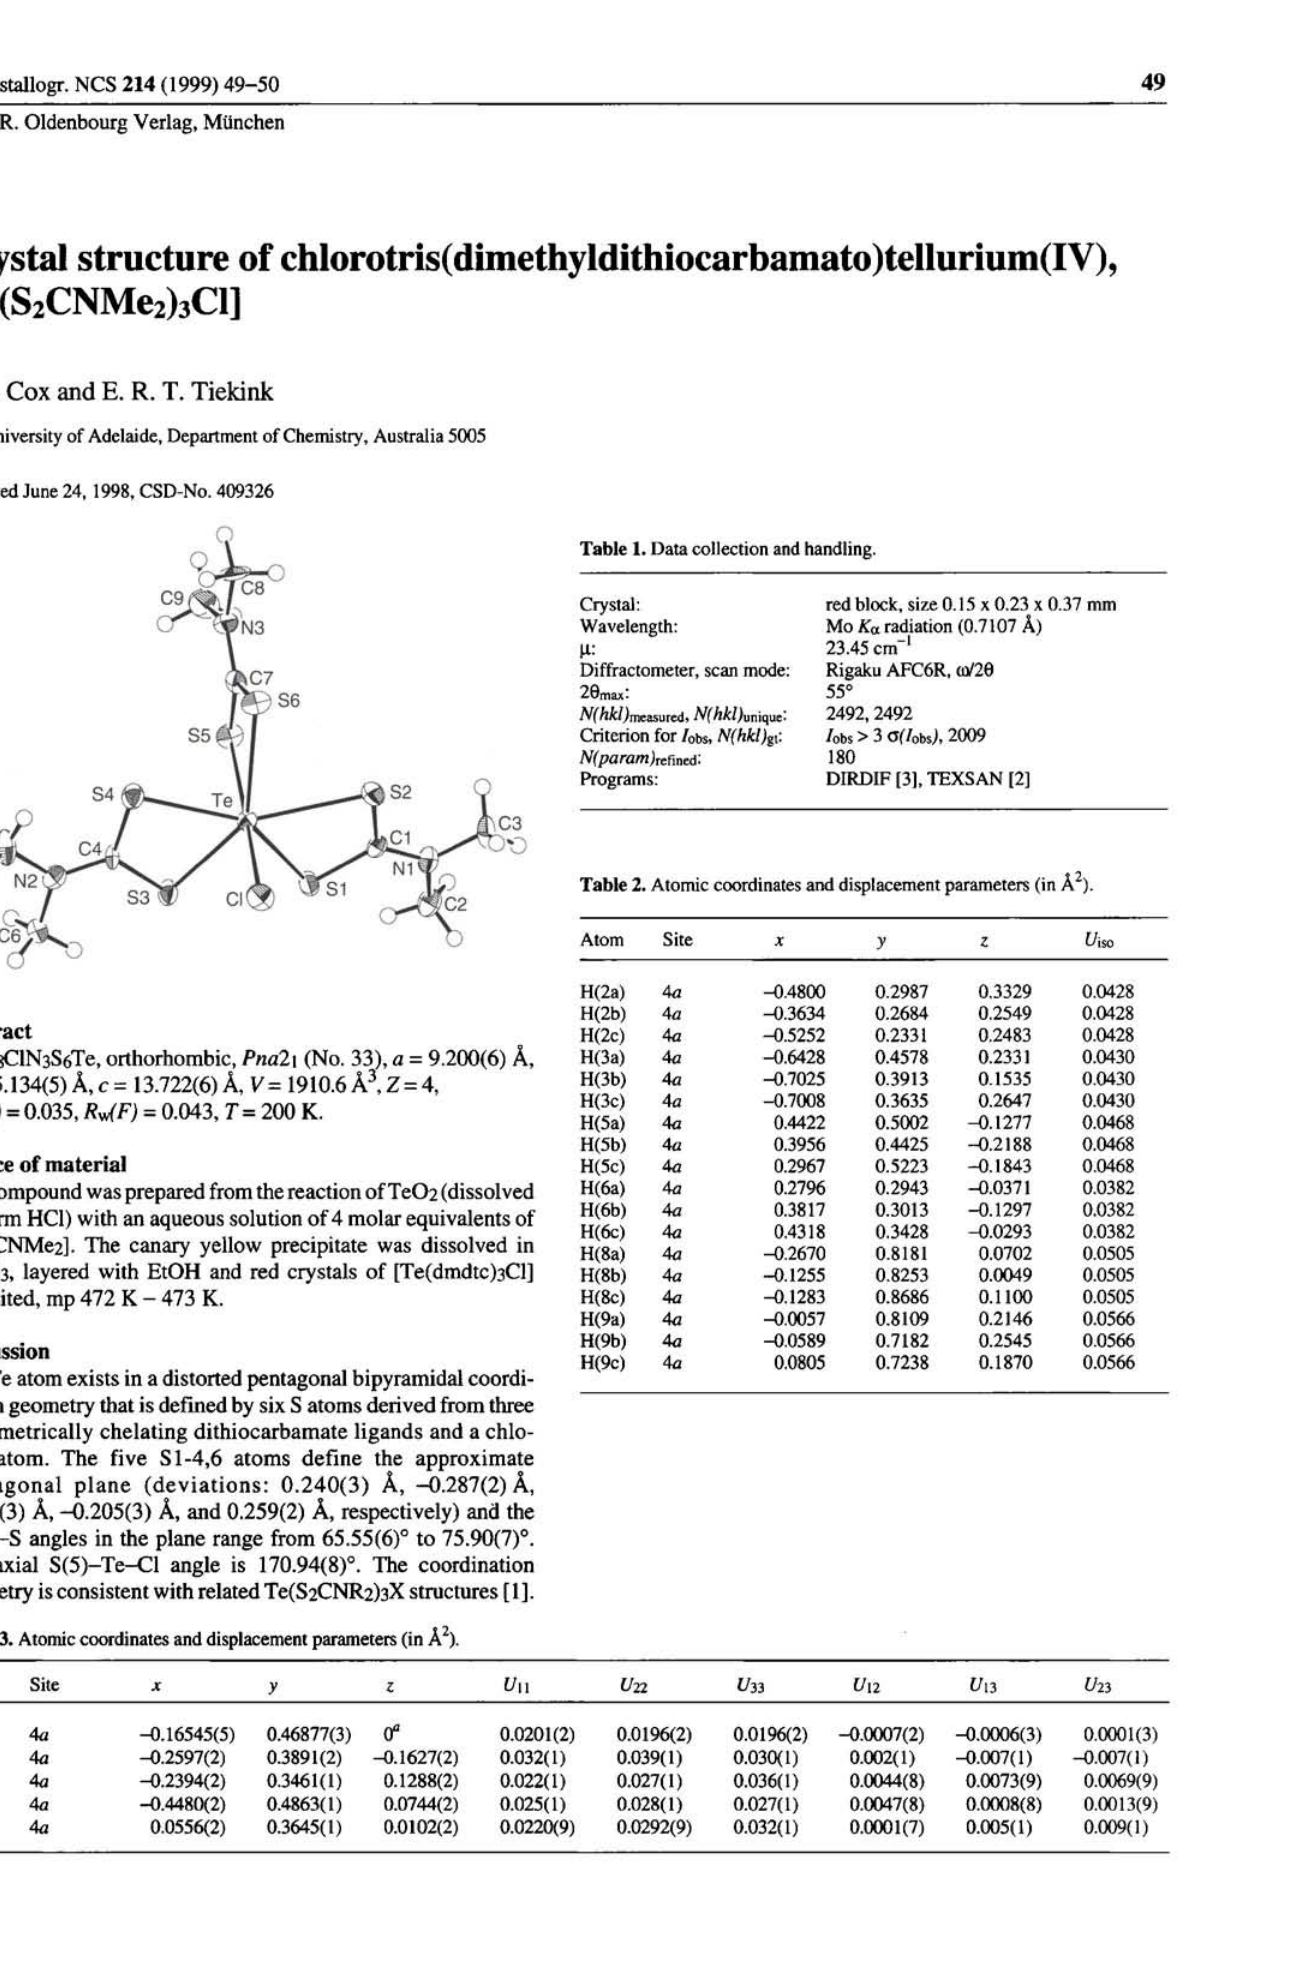
Table 3. Atomic coordinates and displacement parameters (in Â 2 ).